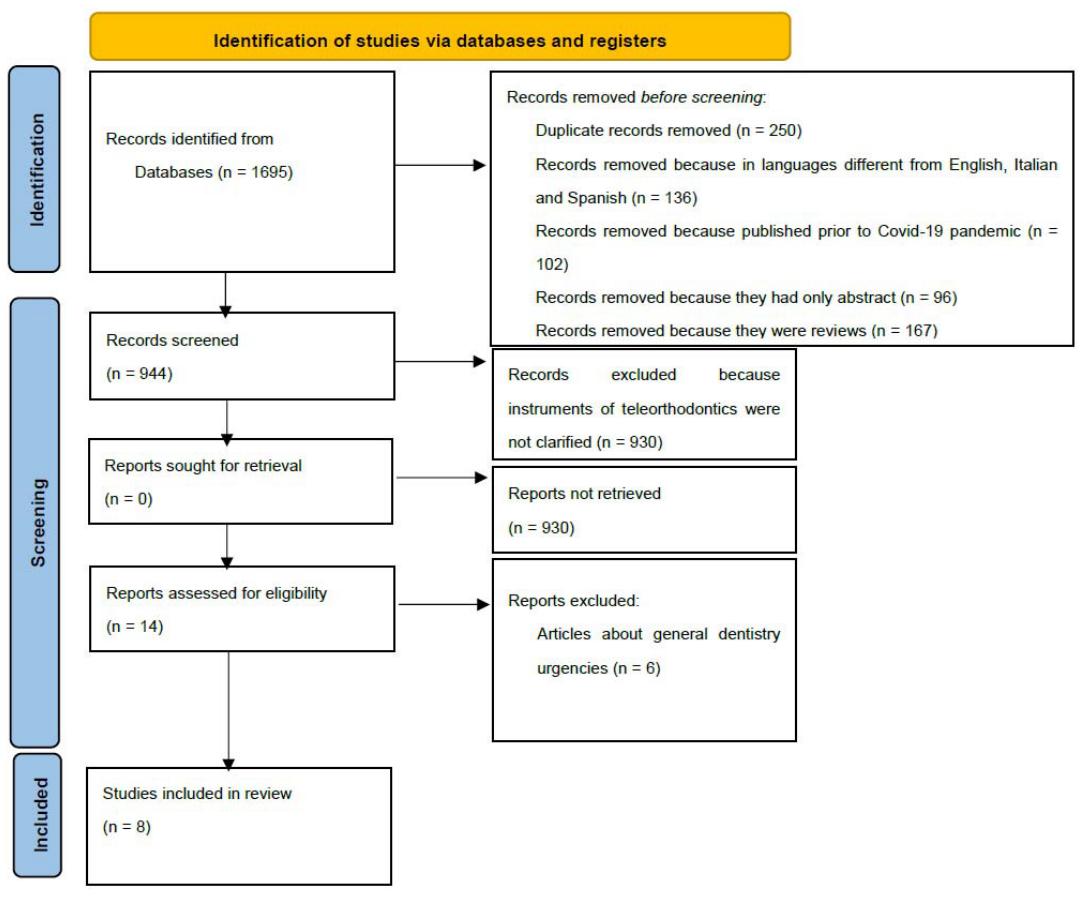
Figure 1. Identification of studies via databases and registers. Figure 2. Identification of studies via databases and